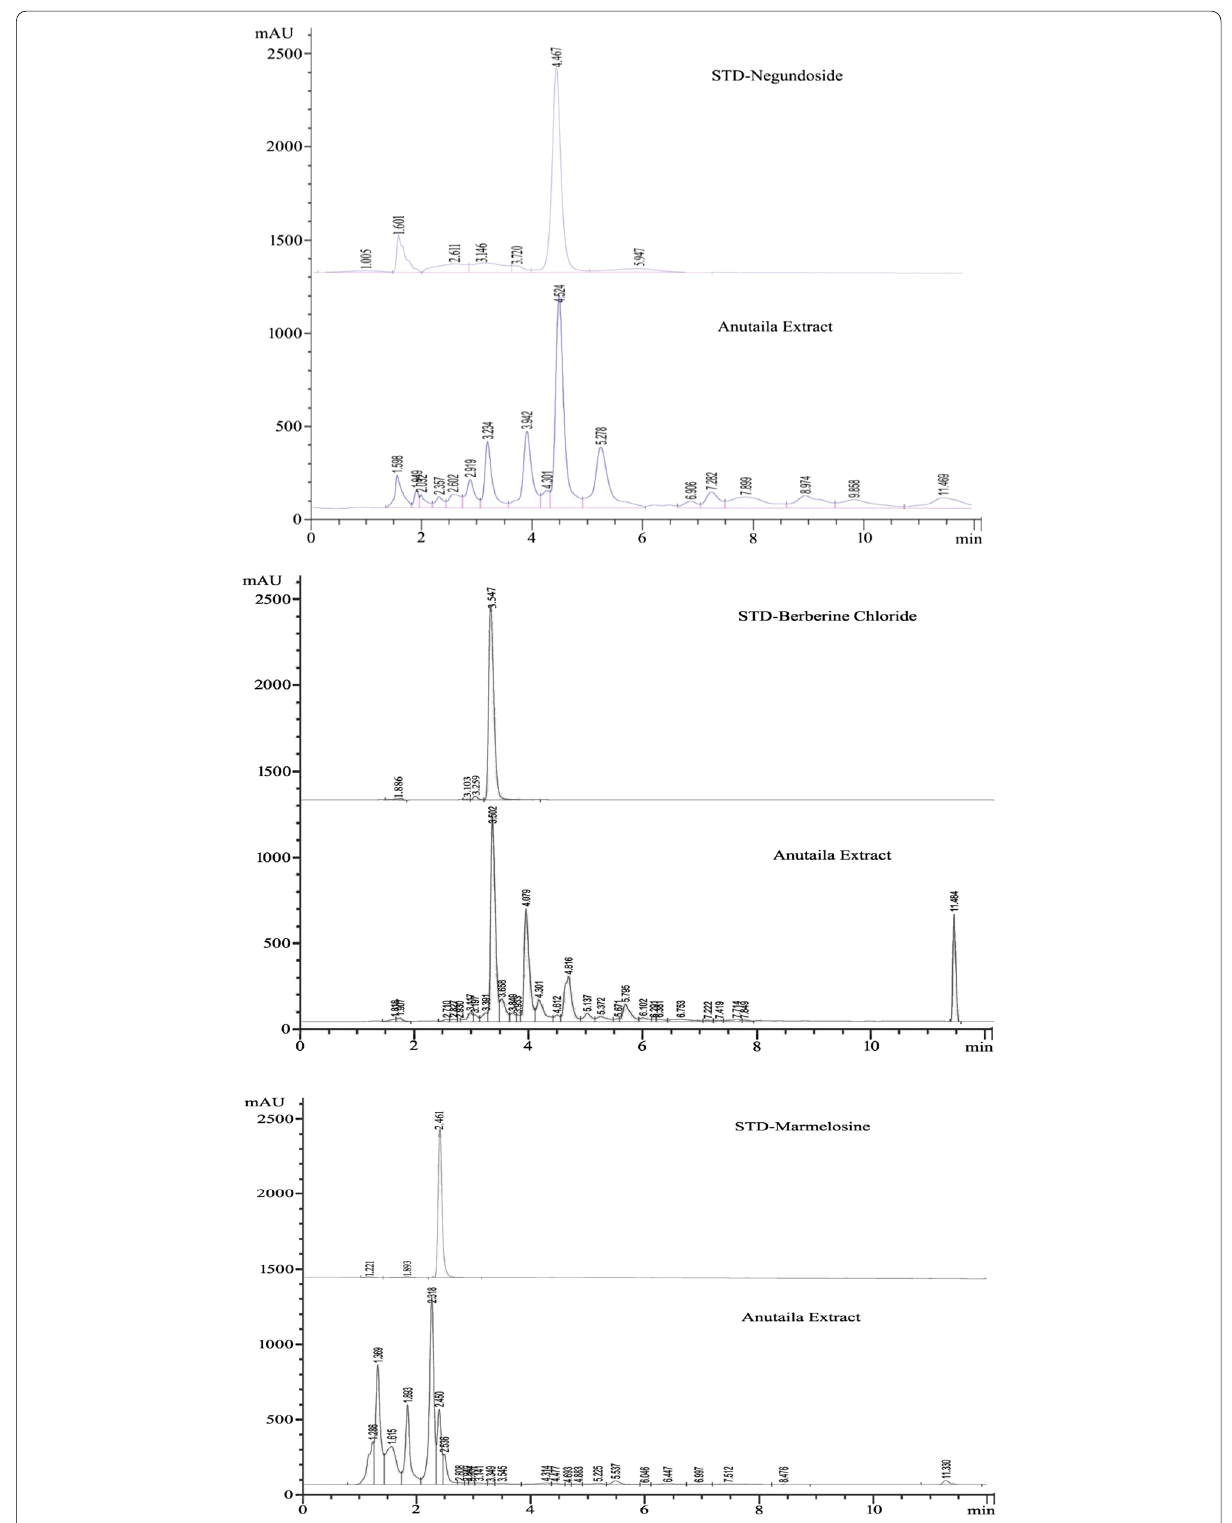
Fig. 3 HPLC chromatogram of Negundoside, Marmelosin Berberine chloride standards, and Anu Taila